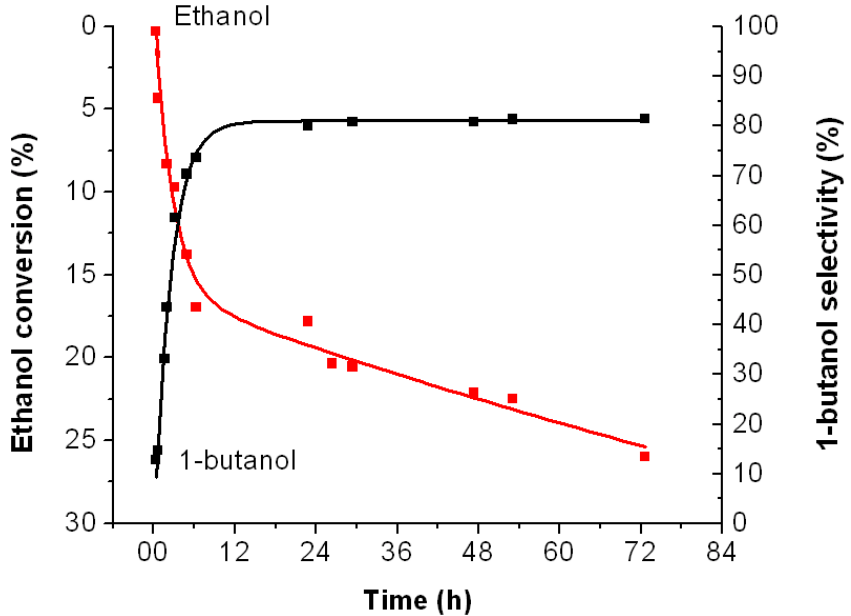
Figure 5. Valorization kinetics of ethanol to 1-butanol over a Ni catalyst (HTC-500) in the batch reactor. Reaction conditions: 250 °C, 70 bar. Selectivity calculated among liquid carbon products.